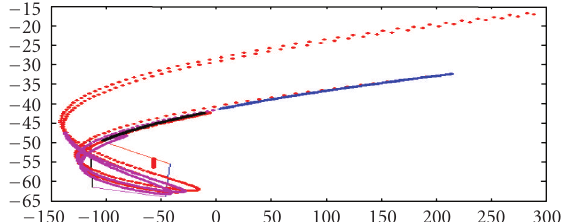
Figure 4.1. The quadrangle D and its image under the mapping P 4 .